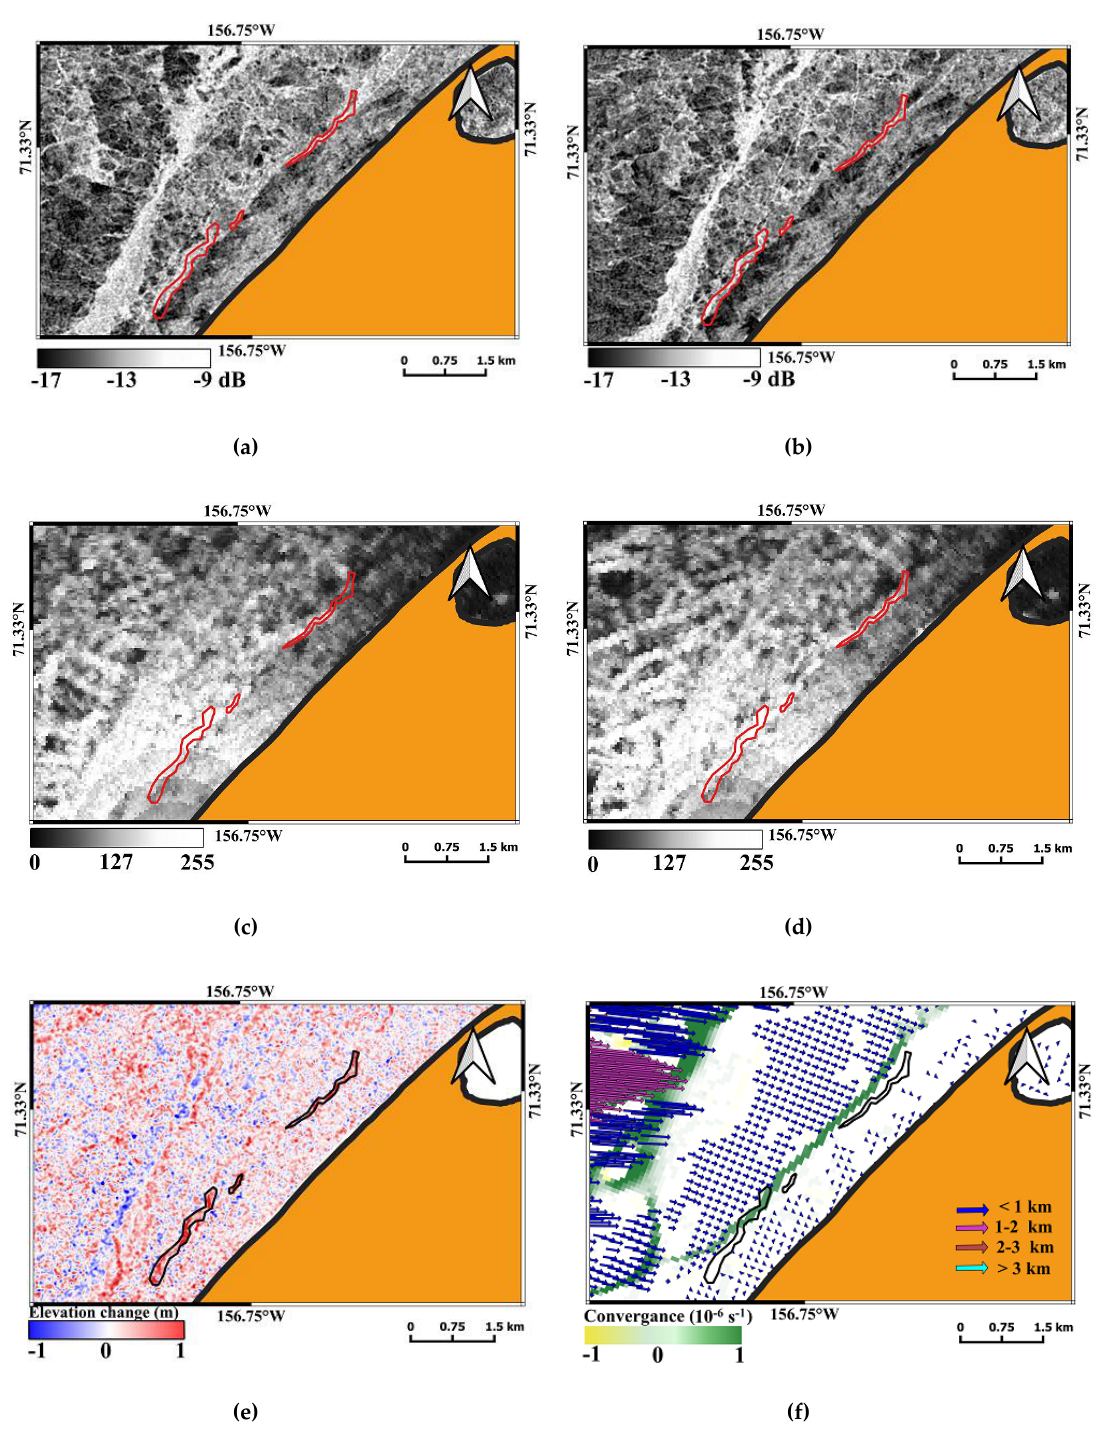
Figure 11. SAR backscatter intensity on the 13 Jan ( a ) and 24 Jan 2012 ( b ). Coastal radar images on 13 Jan ( c ) and 24 Jan 2012 ( d ). The HDM is displayed in ( e ). Results from the drift algorithm are displayed as motion vectors and convergence zones ( f ). Red and black outlines in panels a–f signify the area of ridge development. Land is masked out in orange.